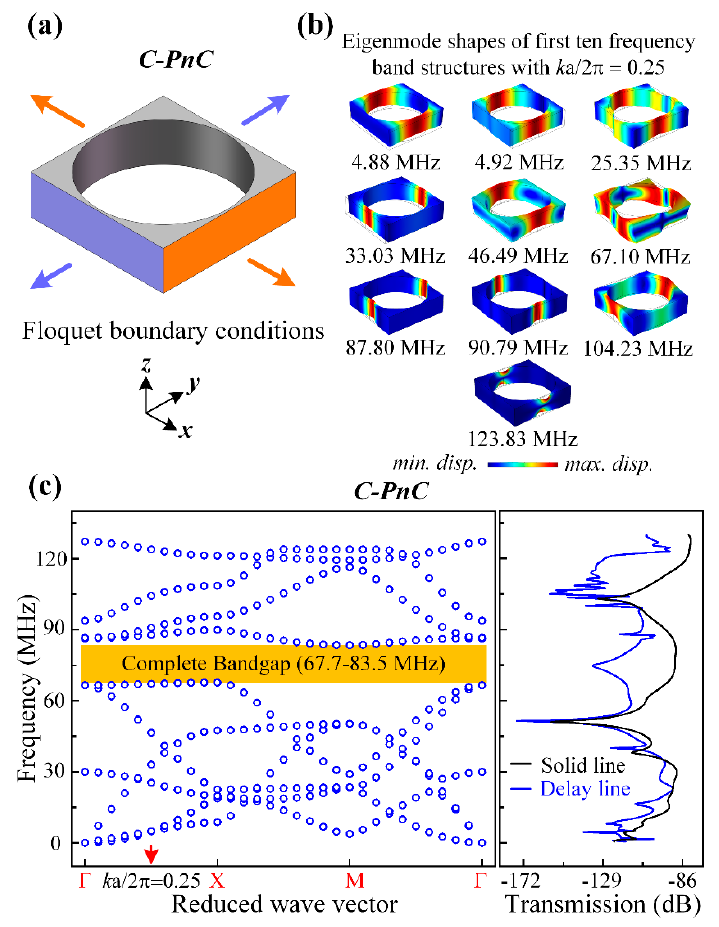
Figure 3. ( a ) 3D Illustration of the Floquet boundary conditions applied to a C-PnC unit cell. The boundary condition applied on the orange surfaces means an infinite number of repetitions in the x -direction, and the condition applied on the purple surfaces means an infinite number of repetitions in the y -direction. ( b ) Corresponding eigenmode shapes of the first 10 frequency band structures for the proposed C-PnC , with k a / 2 π = 0.25. ( c ) Band structures of an infinite PnC are consistent with the transmission characteristics through a finite number of PnC unit cells for C-PnC . The C-PnC shows one complete acoustic bandgap in the frequency range from 67.7 to 83.5 MHz.